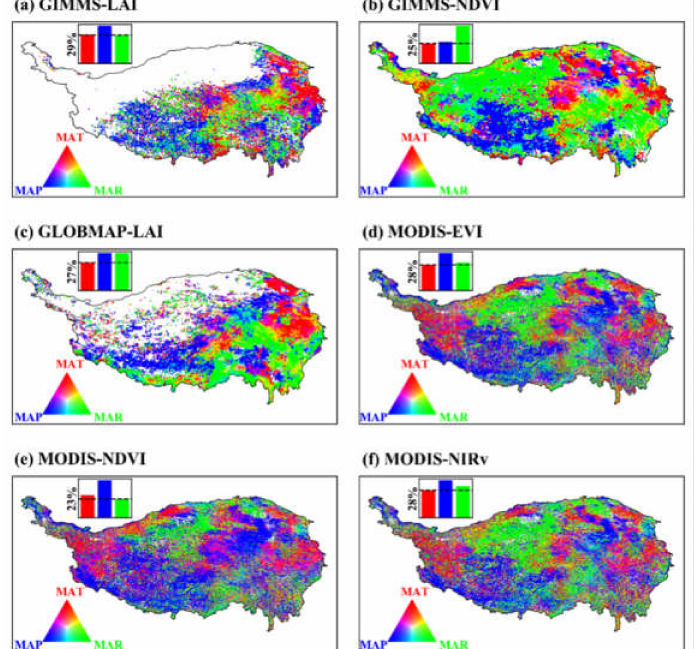
Figure 9. Spatial pattern of the dominated climate factor for VI inter-annual variability from 2001 to 2016. The regions that tend to red, blue, and green color indicate MAT, MAP, and MAR dominated inter-annual variability of VI. The red, blue, and green bars at the upper-left inset denote the percentage of the areas dominated by MAT, MAP, and MAR,